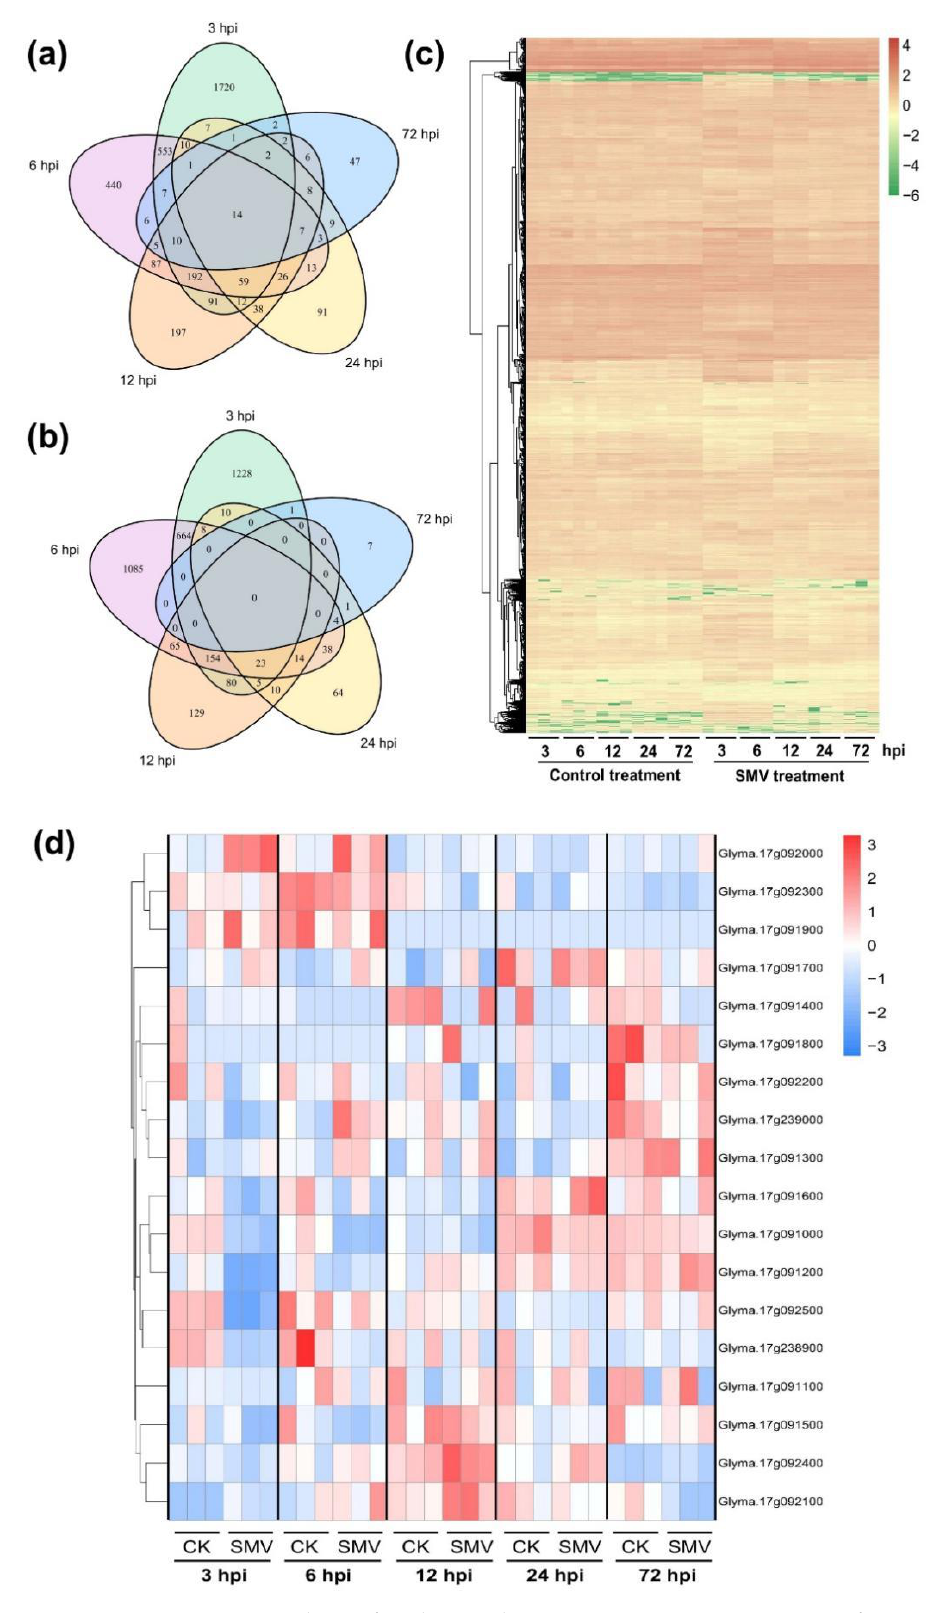
Figure 3. Transcriptome analysis of soybean cultivar SN14 in response to SMV infection. Venn diagram of upregulated ( a ) and downregulated ( b ) differentially expressed genes (DEGs) at 3, 6, 12, 24, and 72 h post-inoculation (hpi); heatmaps of all DEGs ( c ) and candidate genes ( d ) in the regions identified by QTL.